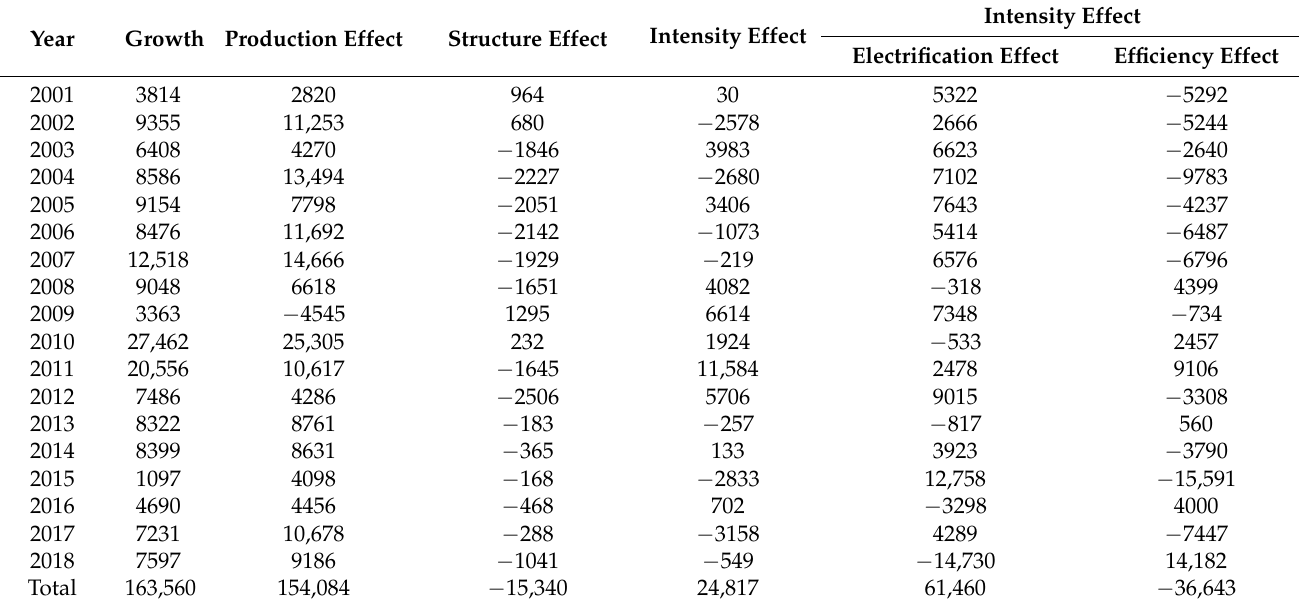
Table 2. Additive LMDI results with a rolling base